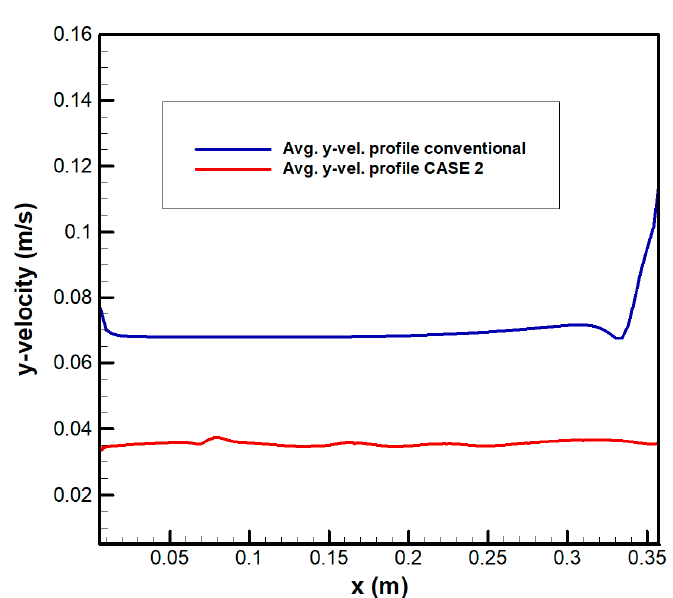
Figure 17. Velocity distribution at the electrode inlet for CASE 2 (location A). Table 7. The difference in pressure drop between conventional design and CASE 2.